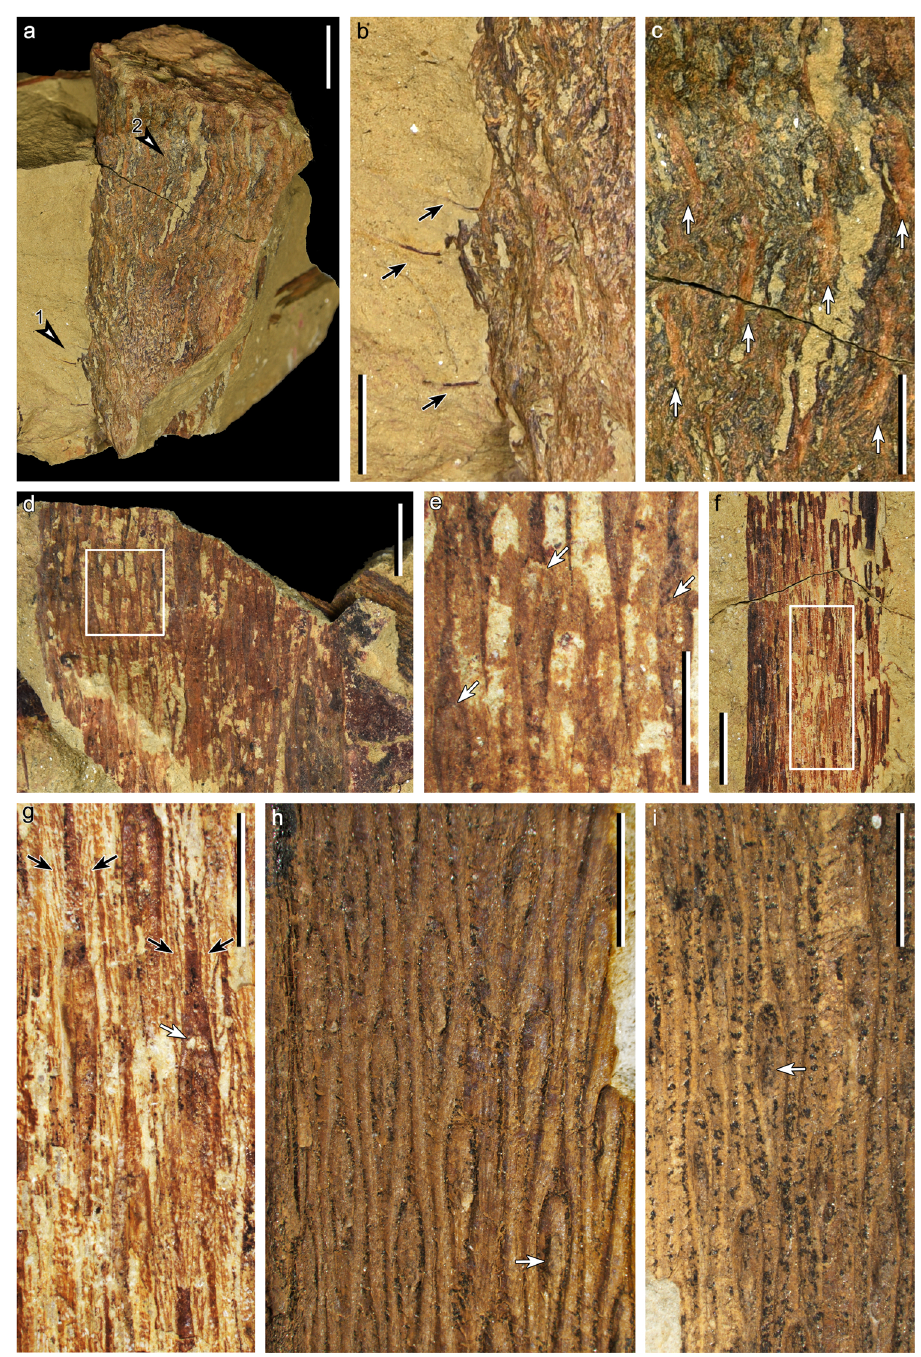
Fig. 1 Aerial axes bearing leaf cushions of Omprelostrobus gigas gen. et sp. nov. Scale bars: a, 2 cm; b – d, f, 1 cm; e, g – i, 5 mm. a Axis cast crossing the bedding plane. Arrows 1 and 2 indicating portion enlarged in b and c , respectively. PKUB19301. b Enlargement of a (arrow 1), displaying leaf remains (arrows). c Enlargement of a (arrow 2), displaying twisted vestiges of leaf cushions/bases (arrows). d A thick axis displaying leaf cushions. Rectangle indicating portion enlarged in e . PKUB19302. e Enlargement of d , displaying fusiform leaf cushions with interspaces. Arrows indicating the arched sutures suggesting the upper margins of leaf scars. f An axis displaying leaf cushions. Rectangle indicating portion enlarged in g . PKUB19303. g Enlargement of f , displaying fusiform leaf cushions and striate ornamentations (paired black arrows) in interspaces. White arrow indicating the arched suture suggesting the upper margin of a leaf scar. h Enlargement of Fig. 4b (arrow), displaying helically arranged fusiform leaf cushions with oblanceolate leaf scars and oval vascular bundle scar (arrow). PKUB19304. i Axis displaying helically arranged fusiform leaf cushions with oblanceolate leaf scars. Arrow indicating probable vascular bundle scar. upper margins of leaf scars, while their lateral margins merge with oblanceolate leaf scar in the middle (Fig. 1h, i, Supplementary those of the leaf cushions. On slenderer axes of ca. 10 mm wide, Fig. 1). The leaf scars are ca. 4.5 mm long. An oval protrusion, the leaf cushions measure ca. 12.0 mm long and ca. 1.3 mm wide 1.8 mm long and 0.7 mm wide, is located in the mid-lower part of (length/width ratio = 9.2:1, n = 6), with each cushion having an the leaf scar (Fig. 1h, arrow), and is interpreted as the vascular